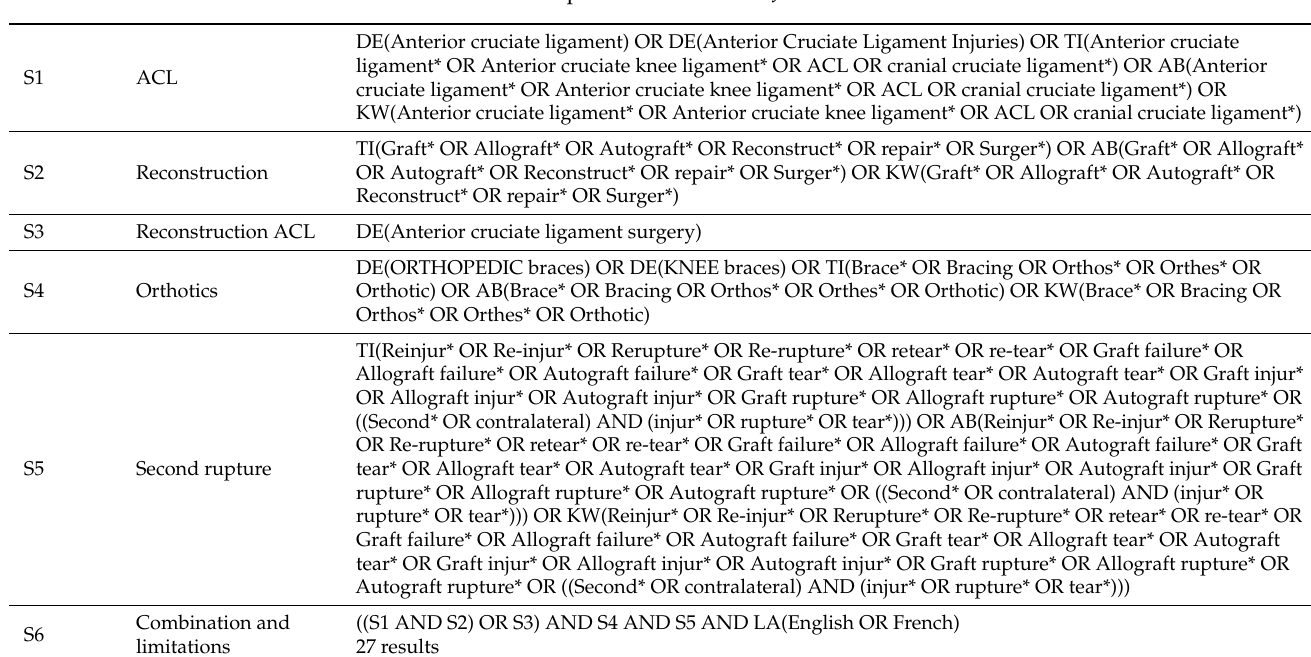
Table A5. Sportdiscus EBSCO 9 June 2020.